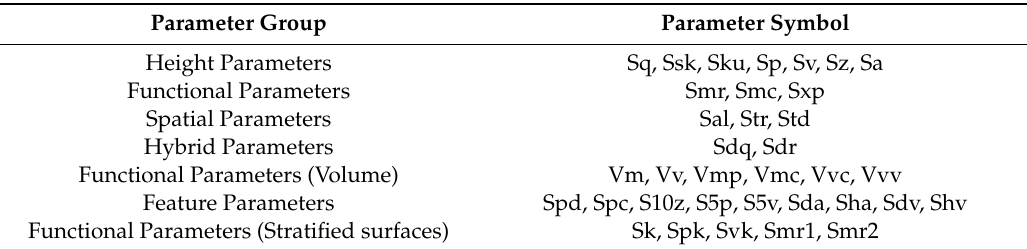
Table 5. ISO areal parameters examined in the